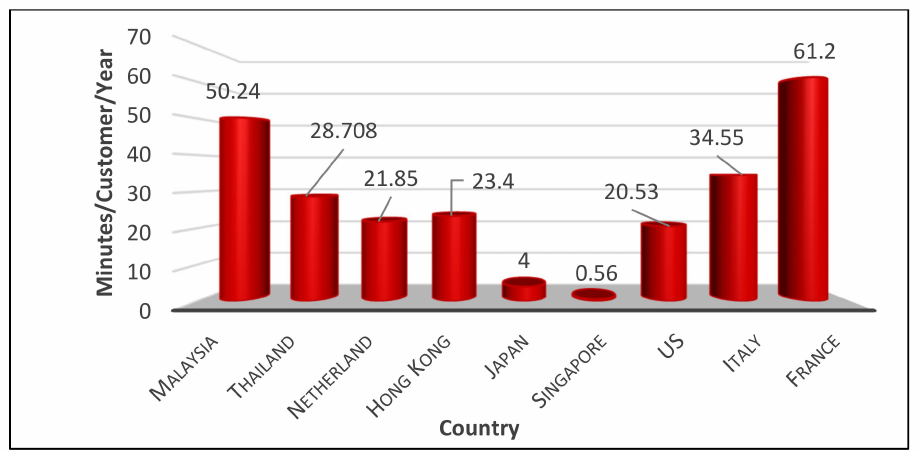
Figure 2. SAIDI performance of distribution system for Malaysia and various cities around the world